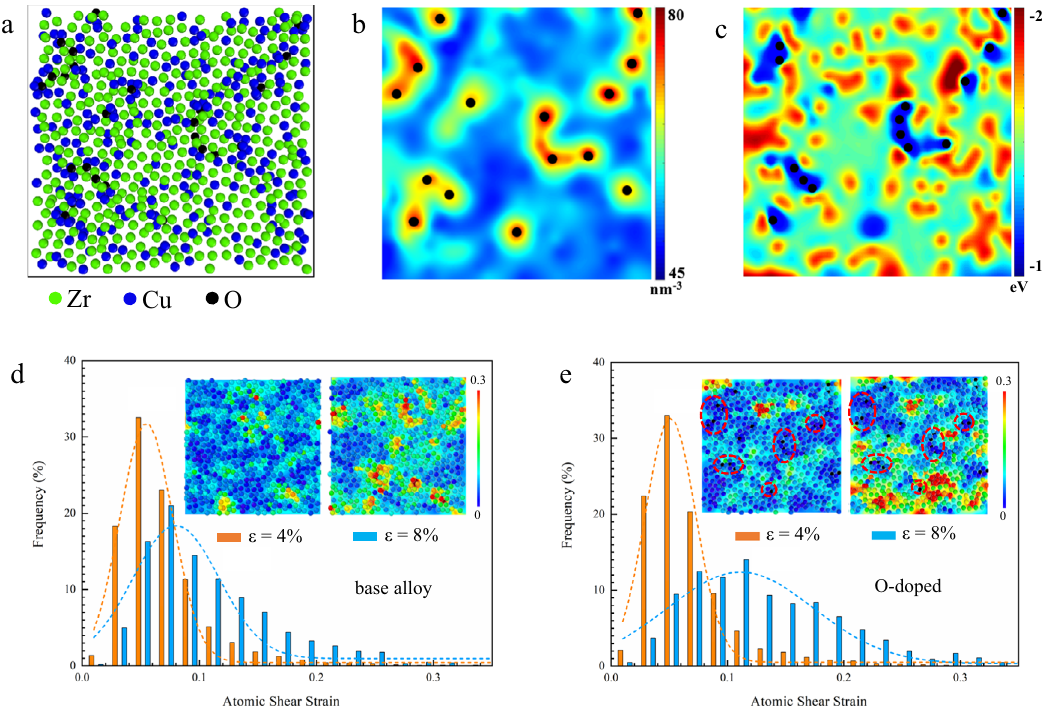
Fig. 5 MD simulations of local atomic packing and shear response of the base alloy and alloy with O doped. A slice (6.25 × 6.25x × 0.35 nm 3 ) taken from a cubic box with 13,500 atoms is shown as a representative example of atomic packing in O-doped MGs. a shows that local regions around doped O atoms are more densely packed. Atomic number density ( b ) and potential energy ( c ) mapping of the O-doped alloy. The distribution histogram of local shear strain for the base ( d ) and O-doped alloy ( e ) at strains of 4% and 8%. Insets in d and e are the atomic shear strain map at a strain of 4% and